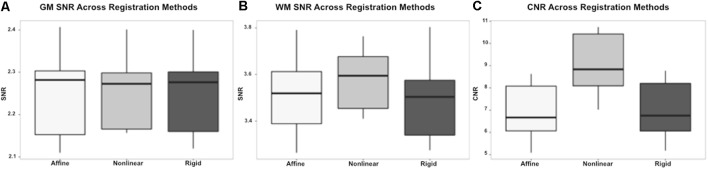
Box and whisker plots demonstrating the signal to noise ratio (SNR) and contrast to noise ratio (CNR) for the different registration methods. (A) Demonstrates the SNR for gray matter (GM) which is similar between methods, with no statistically significant difference. (B) Demonstrates the SNR for white matter (WM) which is higher in the non-linear registration method, though no statistical difference was identified. (C) Demonstrates the CNR of the brain for each registration methods and shows that the non-linear method has the highest CNR. This difference was statistically significant.